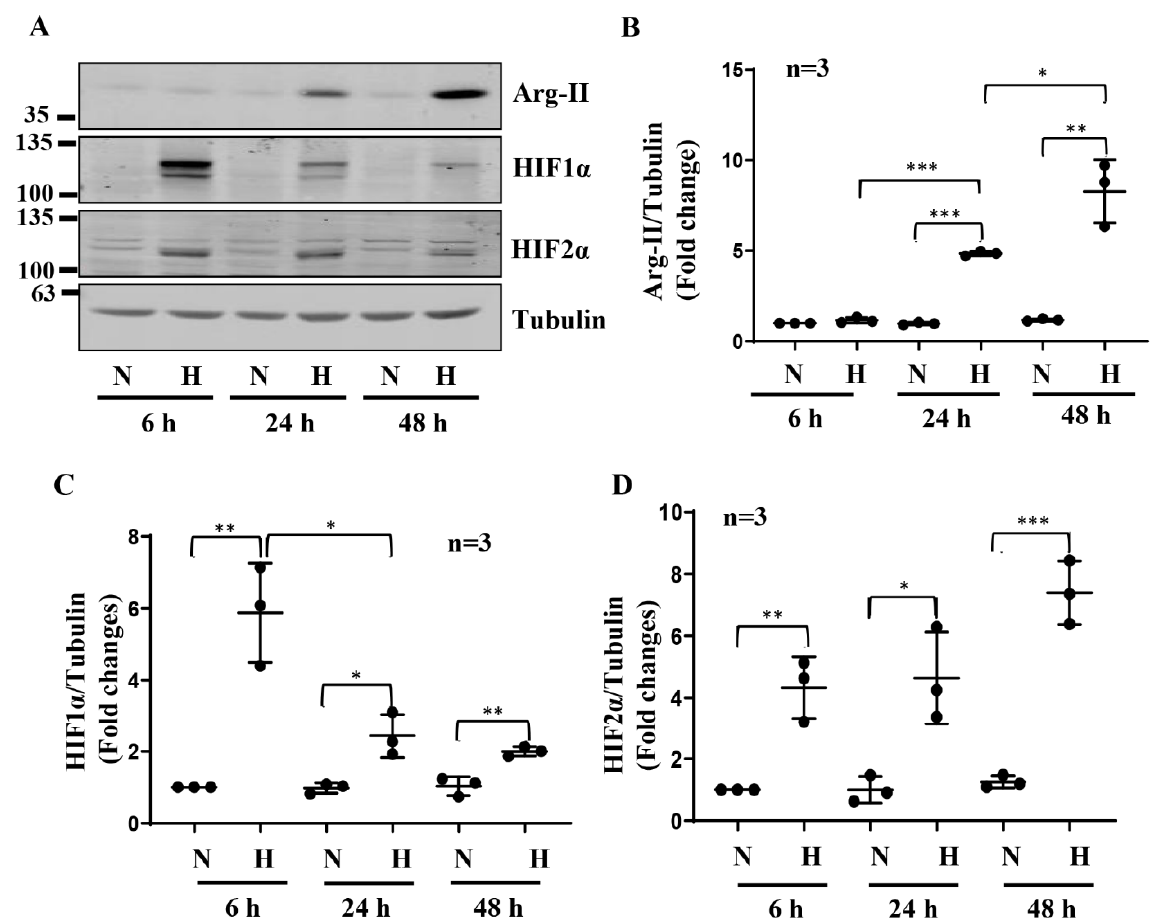
Figure 1. Hypoxia enhances Arg-II levels and HIFs in human podocytes. ( A ) Representative immunoblotting results of the protein levels of Arg-II, HIF1 α , and HIF2 α in different groups of podocytes. Tubulin serves as the loading control. ( B – D ) Quantification of the signals of Arg-II, HIF1 α , and HIF2 α , respectively. * p < 0.05, ** p < 0.01, *** p < 0.001 between the indicated groups. n = 3; N: normoxia; H: hypoxia, h = hours.